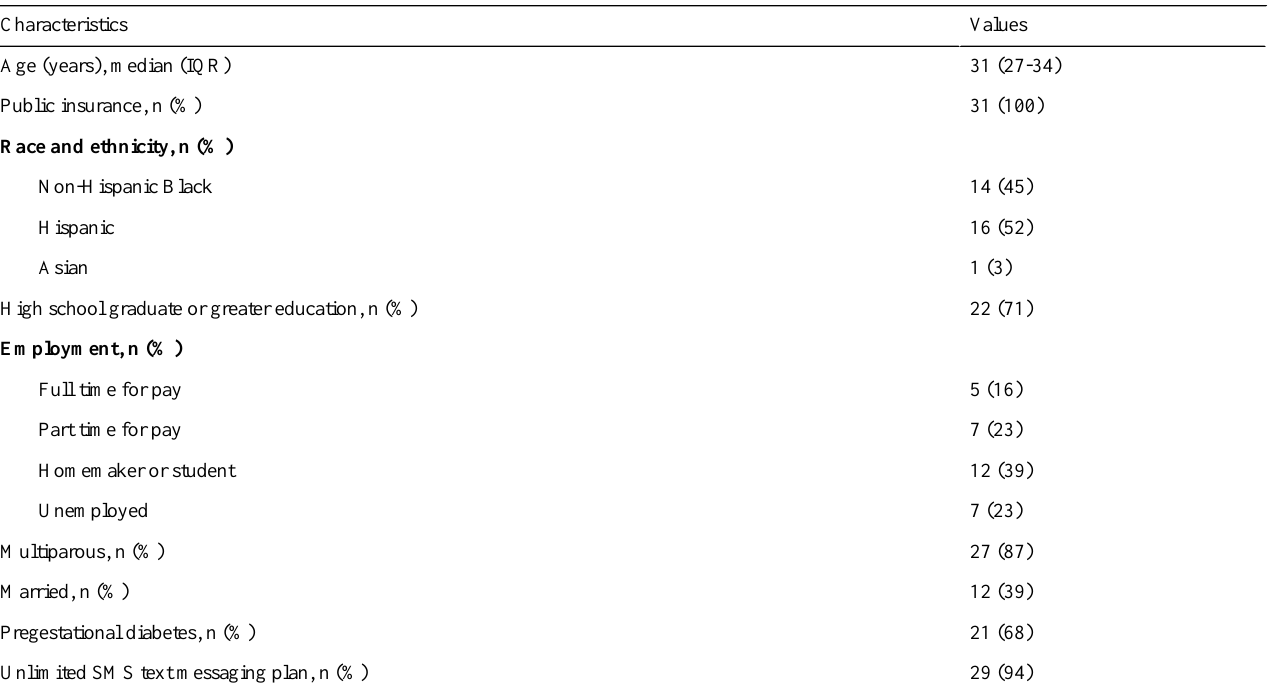
Table 2. Participant demographic characteristics.